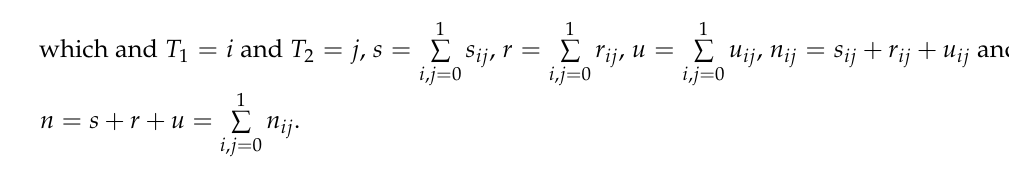
Table 2. Observed frequencies in the presence of partial